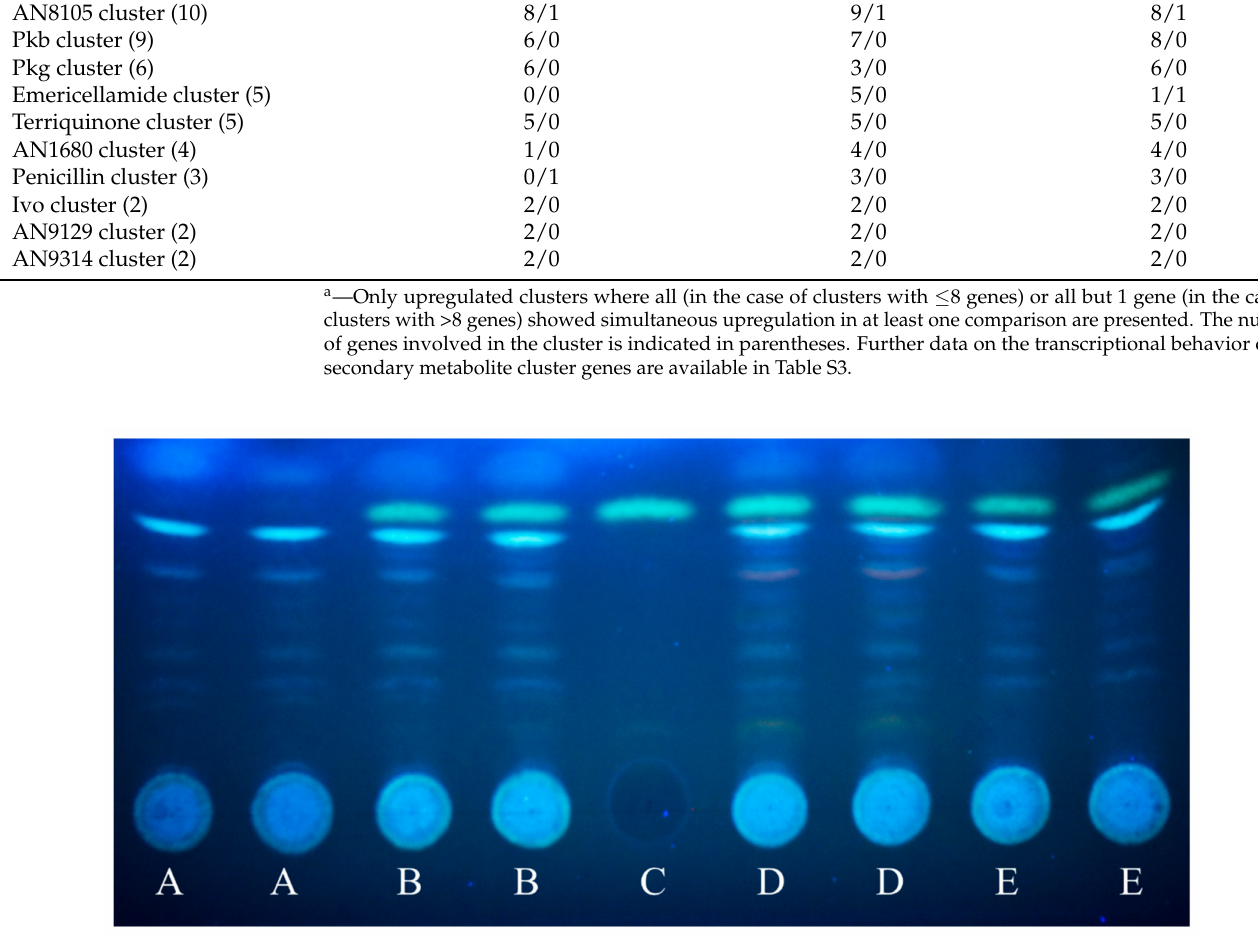
Carbon-Starved vs. Glucose